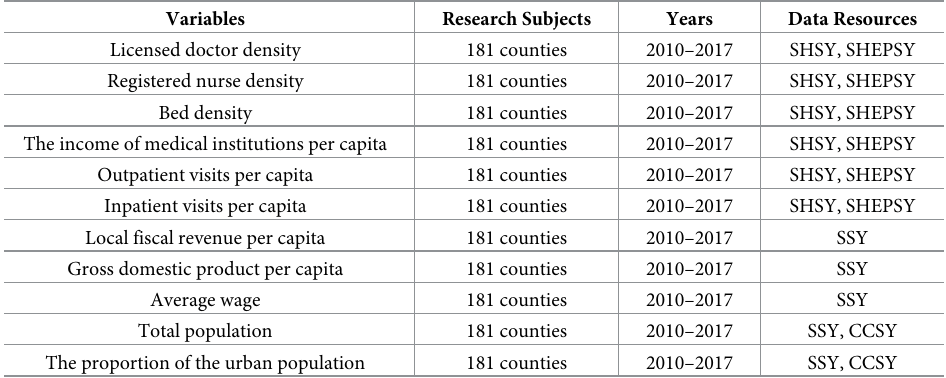
Table 1. Variables and data